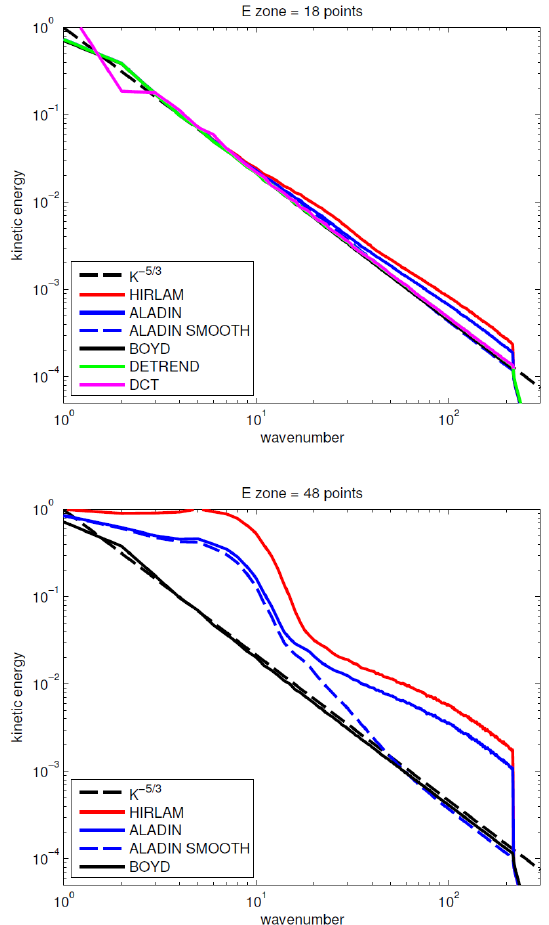
Figure 6. Kinetic energy spectra for all the discussed techniques. The results with two widths of the extension zone are presented for HIRLAM, ALADIN and Boyd methods: a narrower one with 18 points (top) and a wider one with 48 points